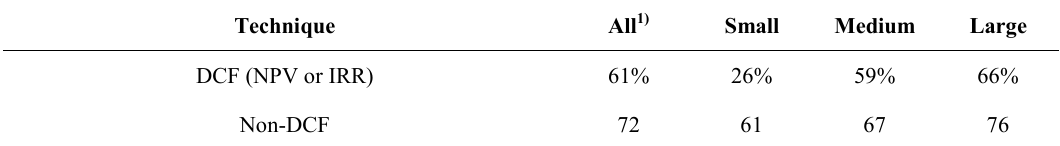
Table 6. The extent to which DCF and Non-DCF techniques are applied to projects (when both are used by a firm) Technique All